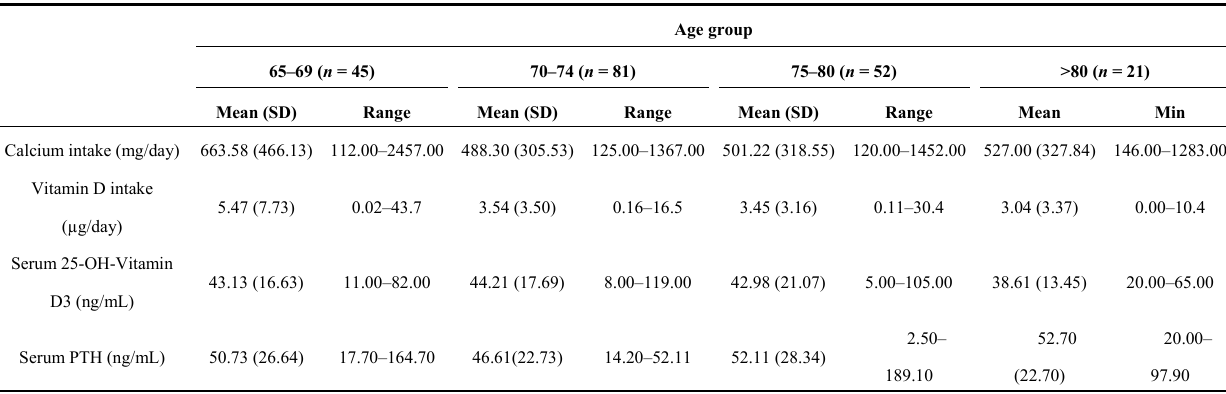
and PTH by age group. 3